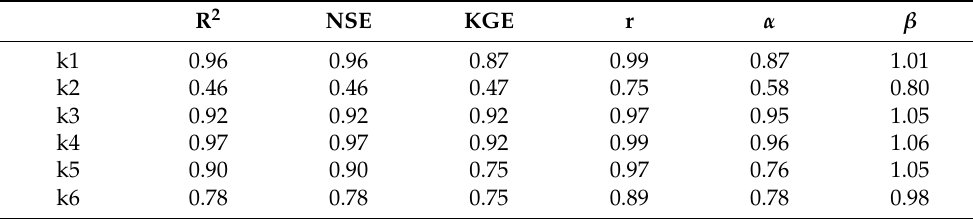
Table 1. Evaluation of high-water